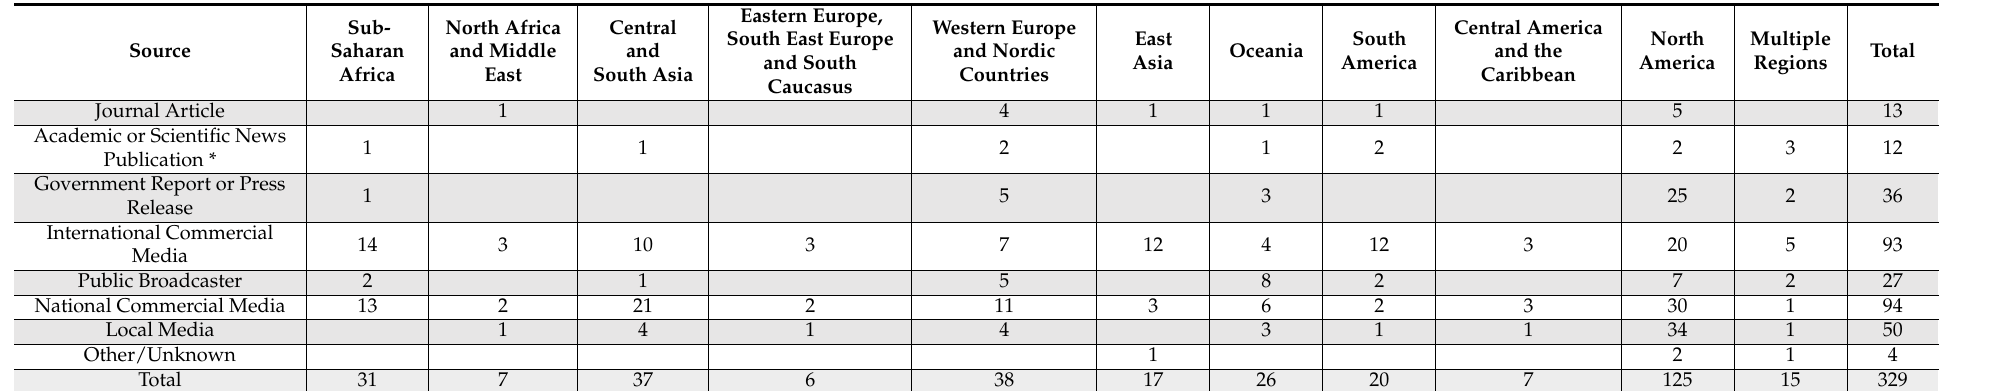
Table 5. News sources and regions ( n =